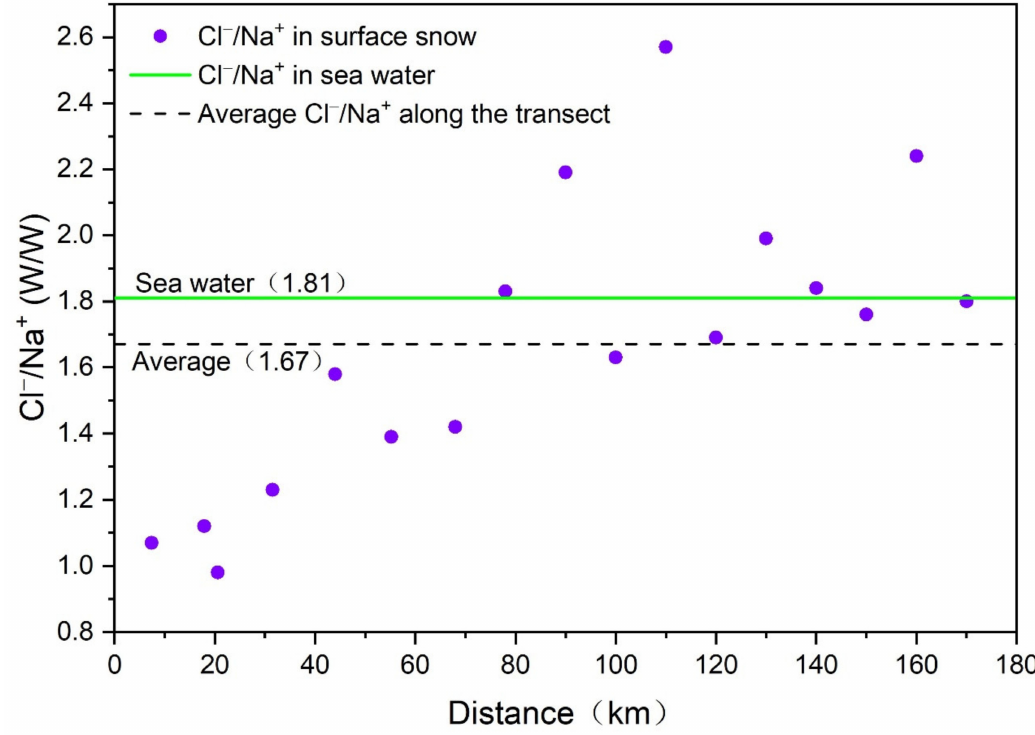
Figure 4. Variation of Cl − /Na + ratios in the surface snow samples from the coast